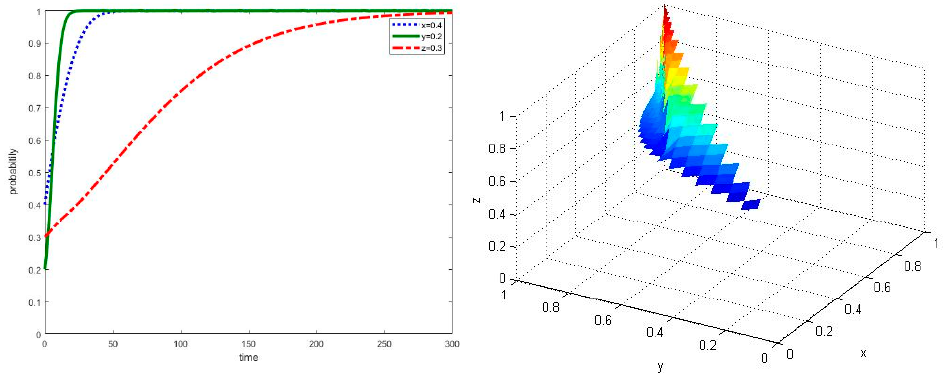
Figure 2. Simulation of dynamic evolution in the scenario of parameters under the conditions of ⑥ .